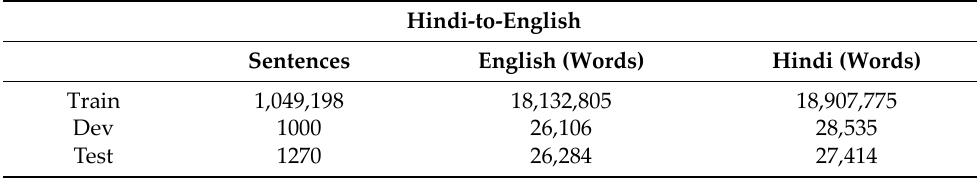
Table 1. Corpus statistics for Hindi‑to‑English.